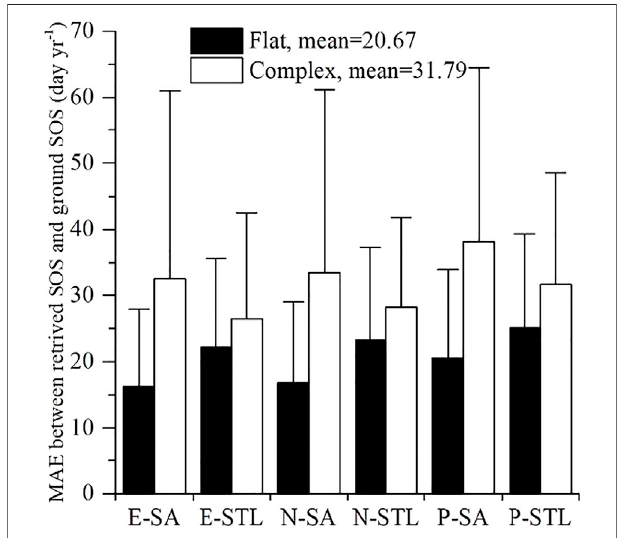
FIGURE 6 | Comparison of mean absolute error (MAE) values of SOS over the fl at terrain and the complex terrain.